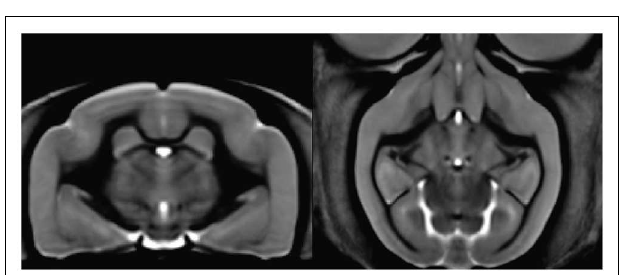
FIGURE 4 | Mouse lemur template from 34 animals. Coronal section of the mouse lemur MRI template (level of hippocampus).